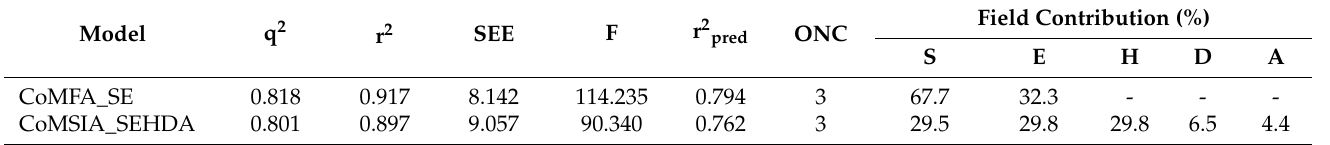
Table 1. Statistical results of the selected CoMFA and CoMSIA models.